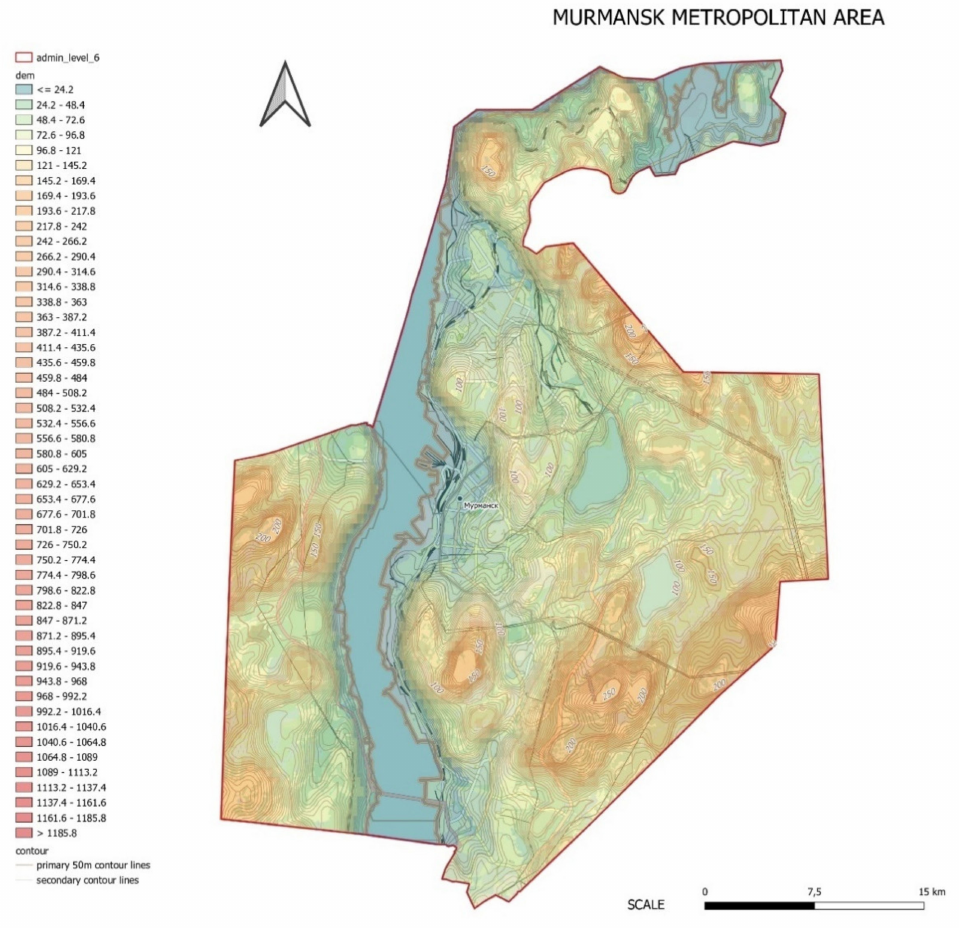
Figure 1. Russian Arctic residential area located on a